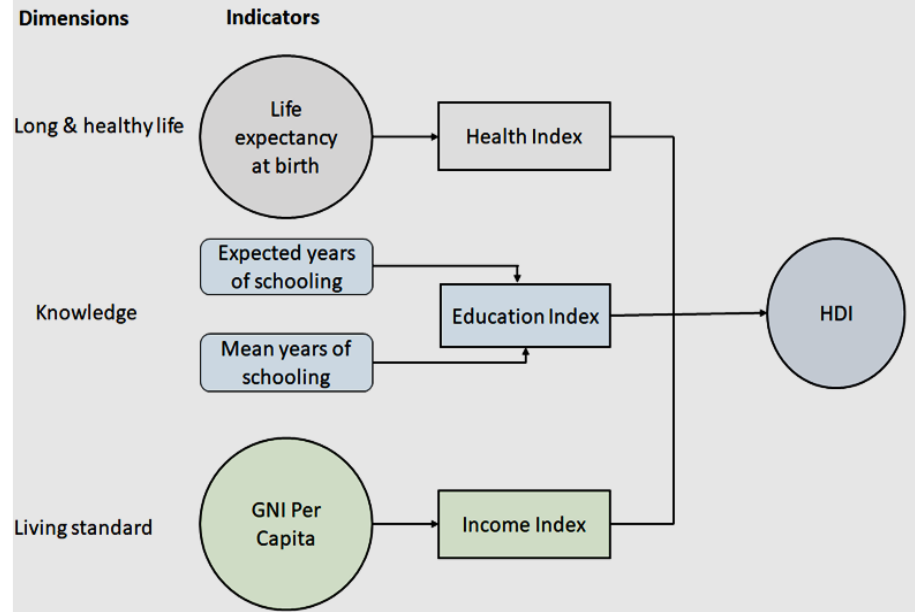
Figure 1. Dimensions of Human Development Index.